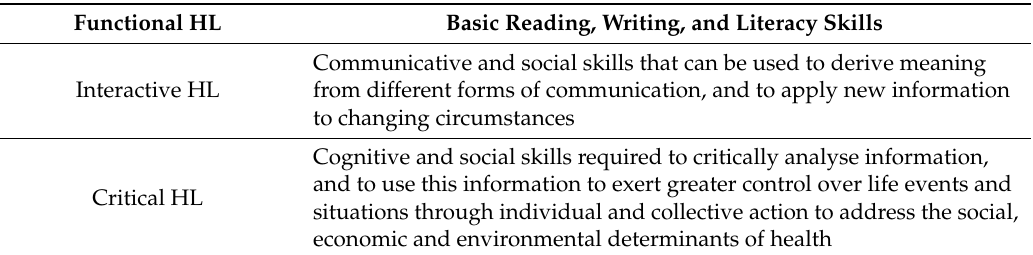
Table 1. Health literacy (HL) definition, according to Nutbeam